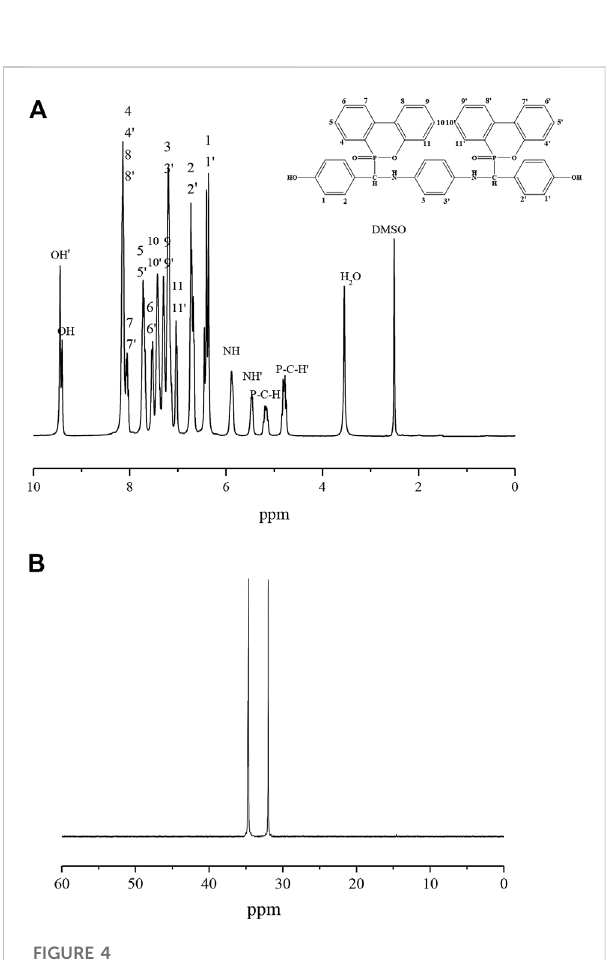
FIGURE 4 1 H NMR spectrum (A) and 31 P NMR spectrum of P-PPD-Ph (B) .